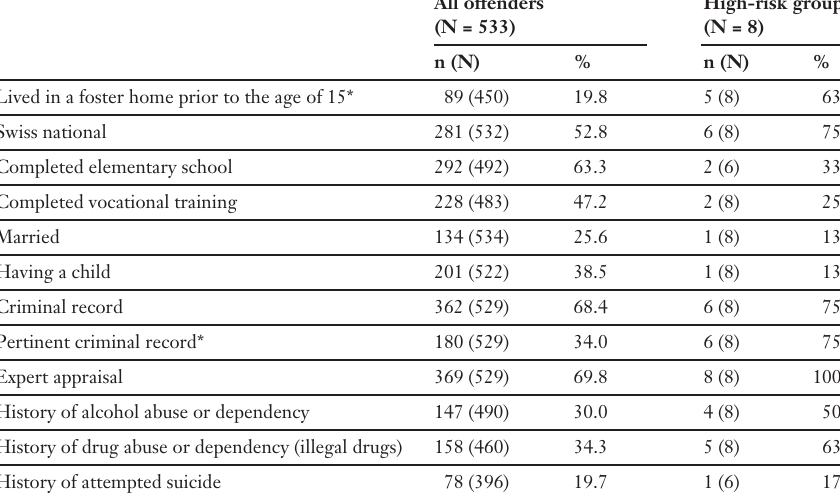
Socio-demographic, biographic, and forensic-psychiatric